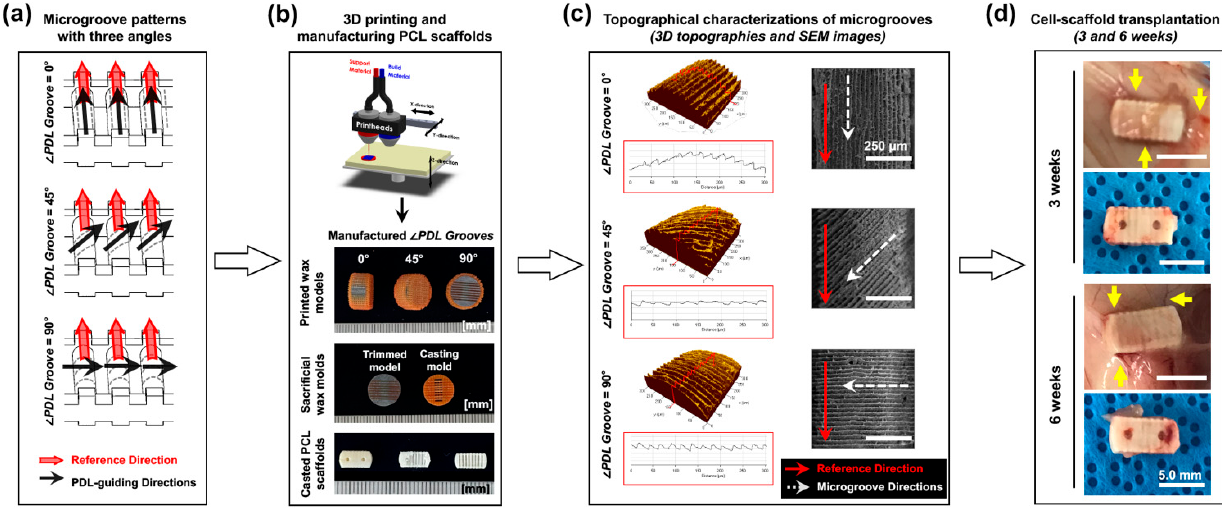
Figure 2. Experimental steps for designing, manufacturing, characterizing, and transplanting scaffolds. ( a ) Three different angulated microgroove patterns are designed and created on surfaces of periodontal ligament (PDL)-guiding architectures ( ∠ PDL groove = 0 ◦ , ∠ PDL groove = 45 ◦ , and ∠ PDL groove = 90 ◦ ). ( b ) Polymer casting wax molds are manufactured using 3D printing system and poly- ε -caprolactone (PCL) scaffolds are created by casting PCL to the casting mold, which could be obtained after removing blue wax material (build material) from the trimmed models. ( c ) The confocal microscope is utilized to characterize surface topographies with three different angles. The red boxes demonstrate that topography profiles can show specific groove intervals (25.40 µm). Moreover, a scanning electron microscope (SEM) can provide a high correlation of the microgroove patterns and 3D topographic images by the confocal microscope images. ( d ) After rat PDL cells are seeded into the scaffolds, cell-scaffold constructs are transplanted subcutaneously and harvested at 3- and 6-week timepoints. Yellow arrows indicate blood vessels, which are formed arou n d scaffolds.